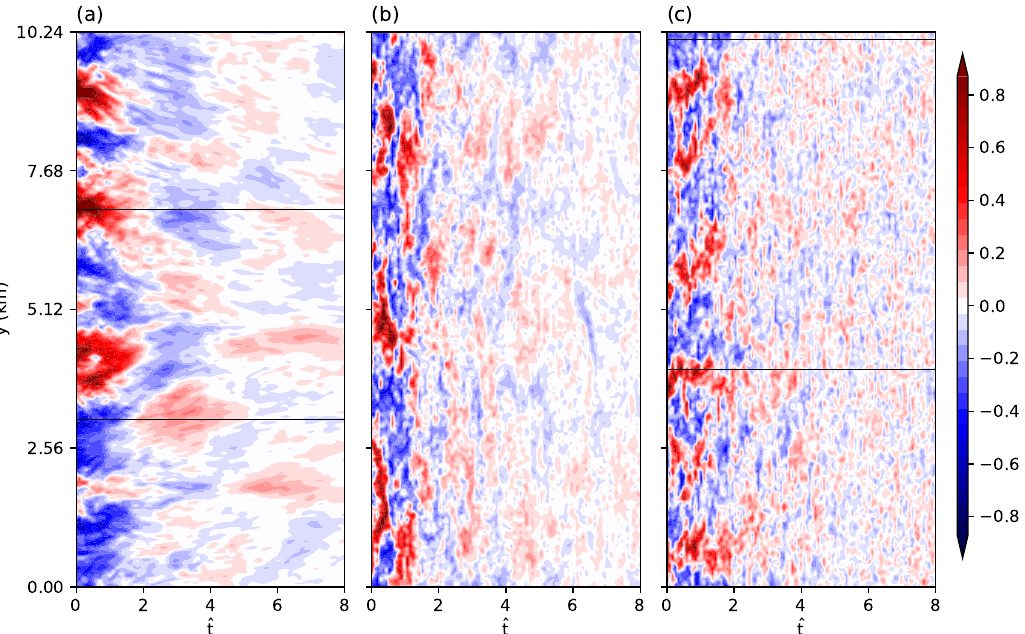
Figure 5. Time series of normalized and boundary-layer-averaged vertical velocity at x = 2.23 km in the ( a ) B3, ( b ) I2, and ( c ) S1 cases. The black lines indicate the position of the ˆ t - z plane in Figure 6.